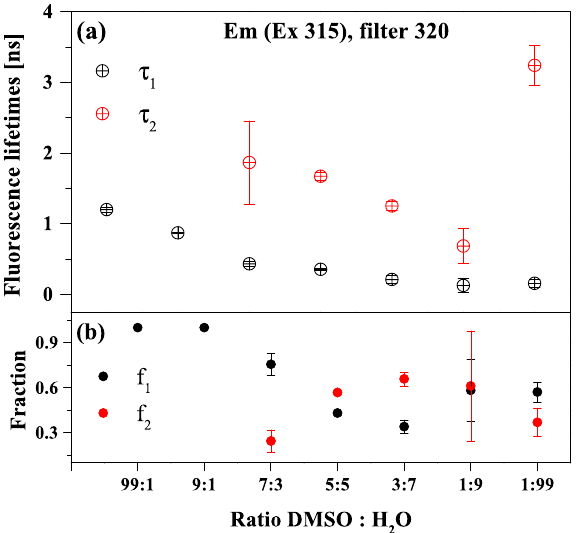
Figure 10. Fluorescence lifetimes (panel a), fractional intensities (panel b) and appropriate standard deviations measured for NTBD at various DMSO: H 2 O volume ratios using 320 nm filter.